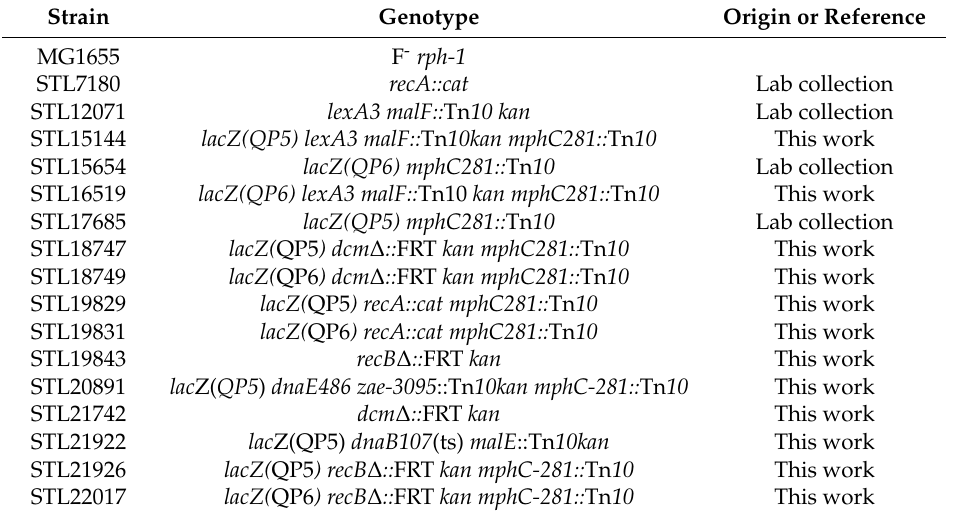
Table 1. Escherichia coli K-12 strains used in this